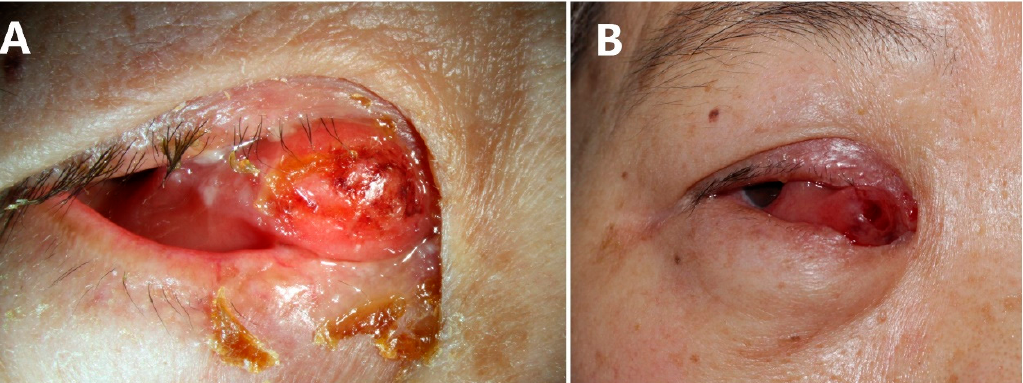
Figure 1. Extraocular manifestations. ( A ) Clinical features during the first visit to our hospital. Salmon-colored mass in the right inner canthus and external deviation of the eyeball. This was accompanied by a small amount of purulent discharge and superficial ulceration. ( B ) Before the operation and removal of the surface discharge.